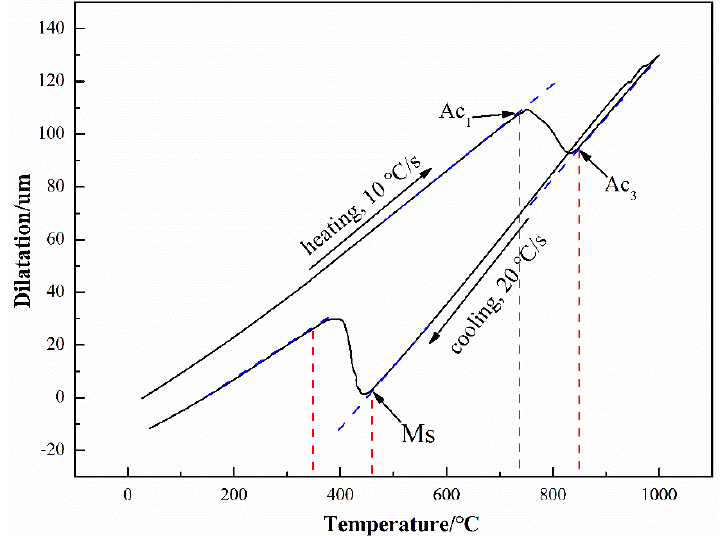
Figure 1. Dilatation vs. temperature curve of LH800 steel.